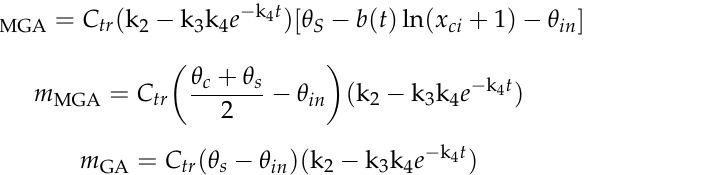
Figure 3. Soil moisture profiles simulated with the improved modified Green–Ampt (IMGA) model over time (the dashed line is the soil moisture profile at time i , and the solid line is the moisture profile at a later time f ).